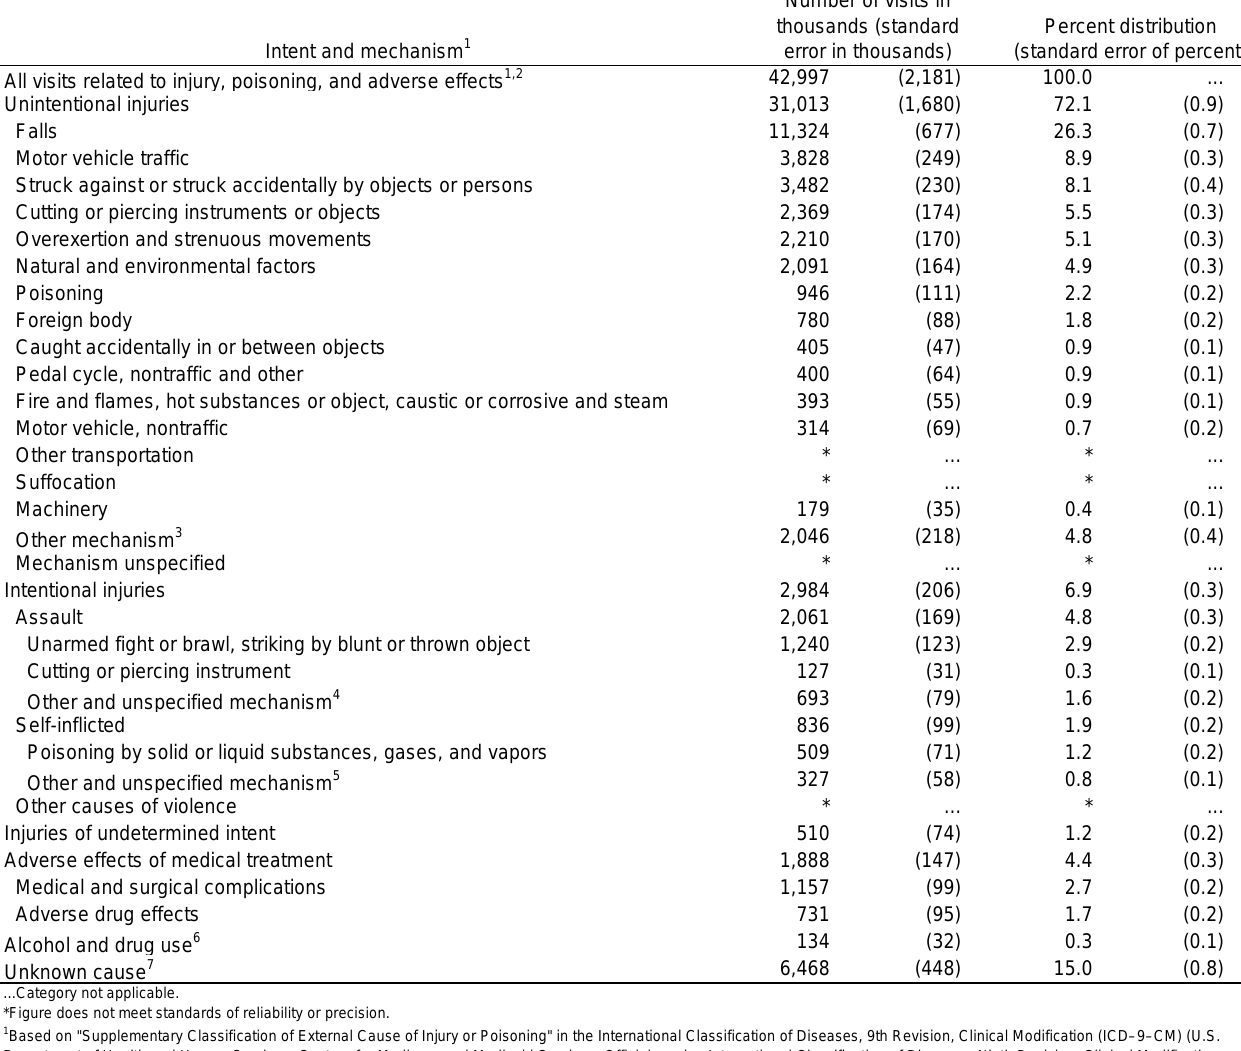
Table 17. Emergency department visits related to injury, poisoning, and adverse effect, by intent and mechanism: United